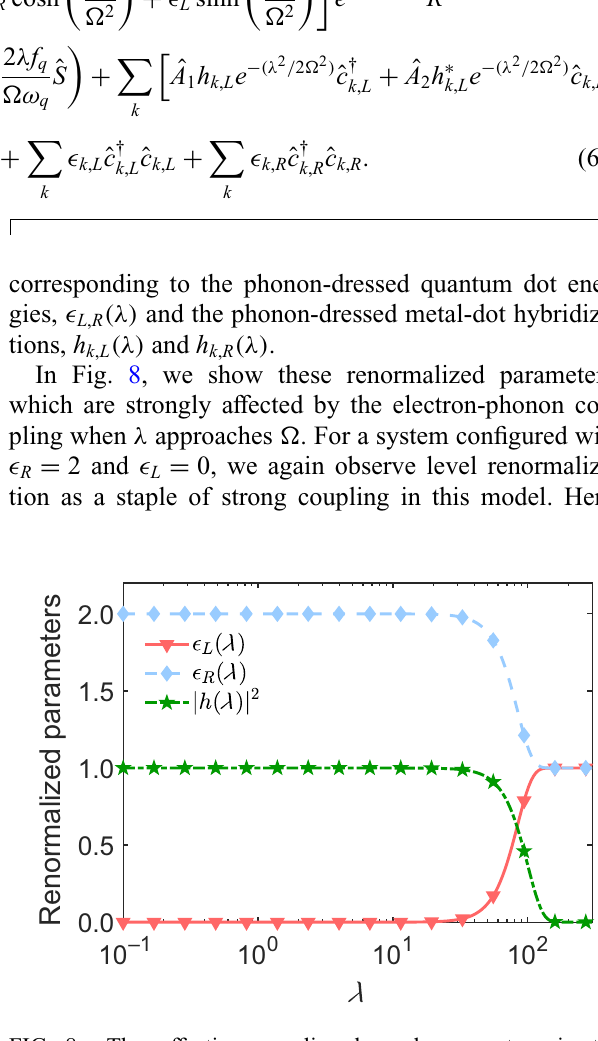
FIG. 8. The effective coupling-dressed parameters in the phonon-assisted quantum dot thermoelectric generator. We dis- play the energy of the left dot (triangle) and the right dot (diamond) and the magnitude squared of the coupling energy between the dots and the fermionic baths (star), as calculated from Eqs. (62)–(64). The parameters (without dressing) are (cid:18) R = 2, (cid:18) L = 0, | h | 2 = 1, and (cid:5) = 100.